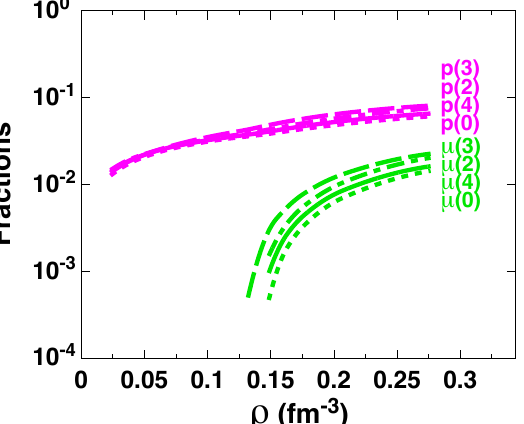
Figure 4. Proton fraction and muon fraction as a function of density. The numbers in the curve labels (0, 2, 3, 4) indicate the chiral orders LO, NLO, N 2 LO, and N 3 LO, respectively. See text for more